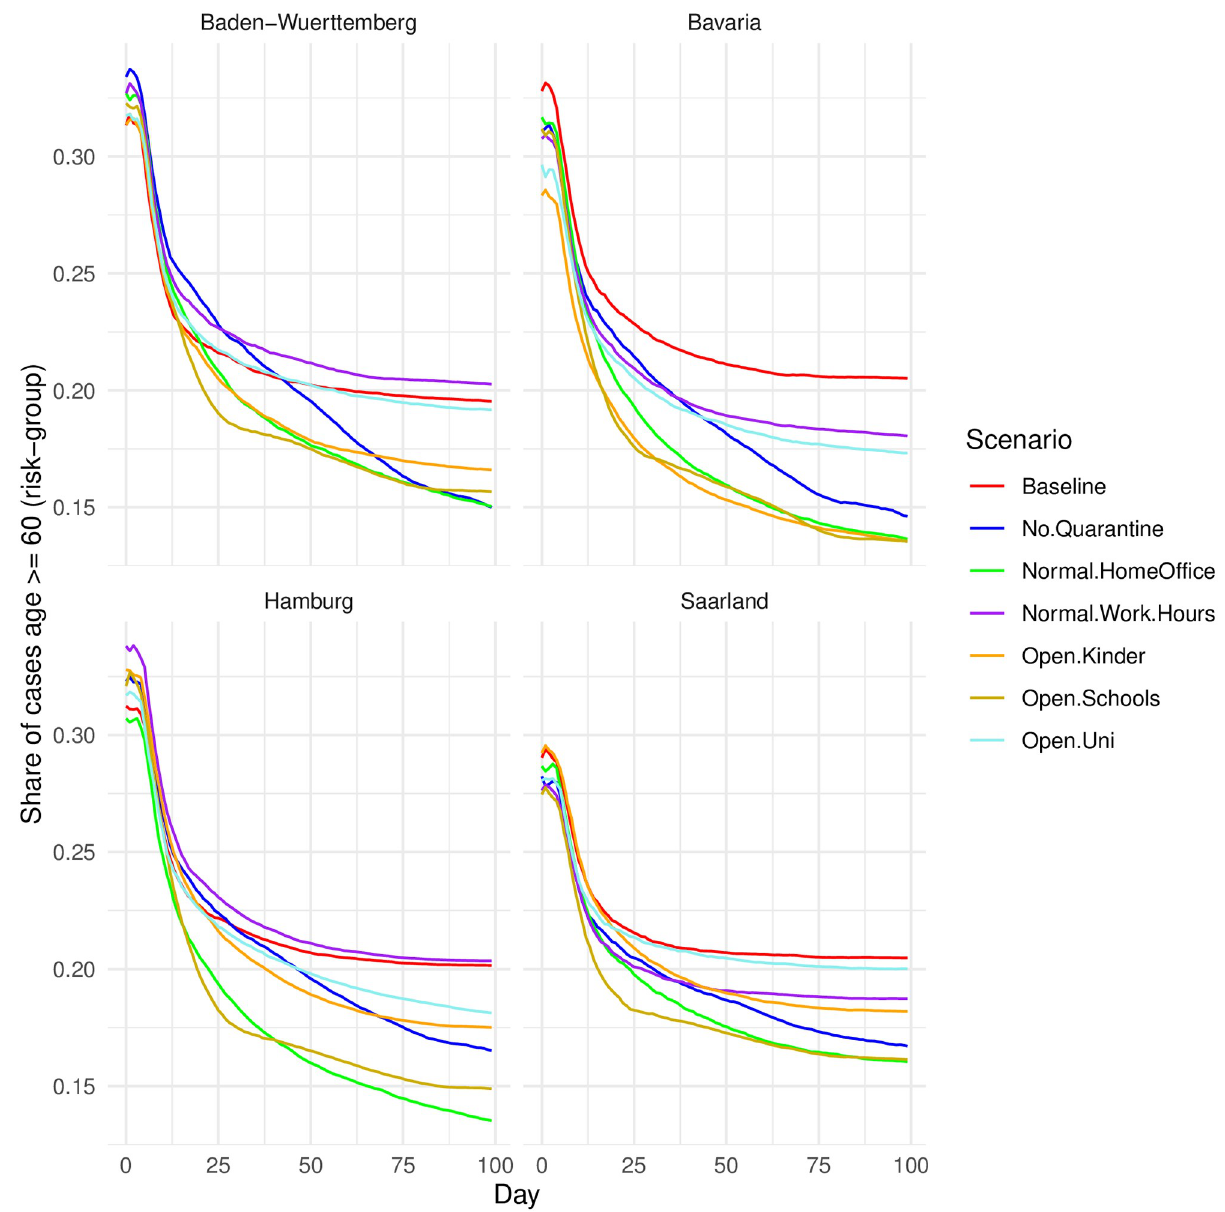
Fig 4. Share of infected agents belonging to the risk-group (age > = 60), by state. Lines represent the share of cumulative cases in the risk group for each NPI over all simulation runs. To facilitate readability, a ribbon of confidence intervals is omitted. Figures including the CIs are available upon